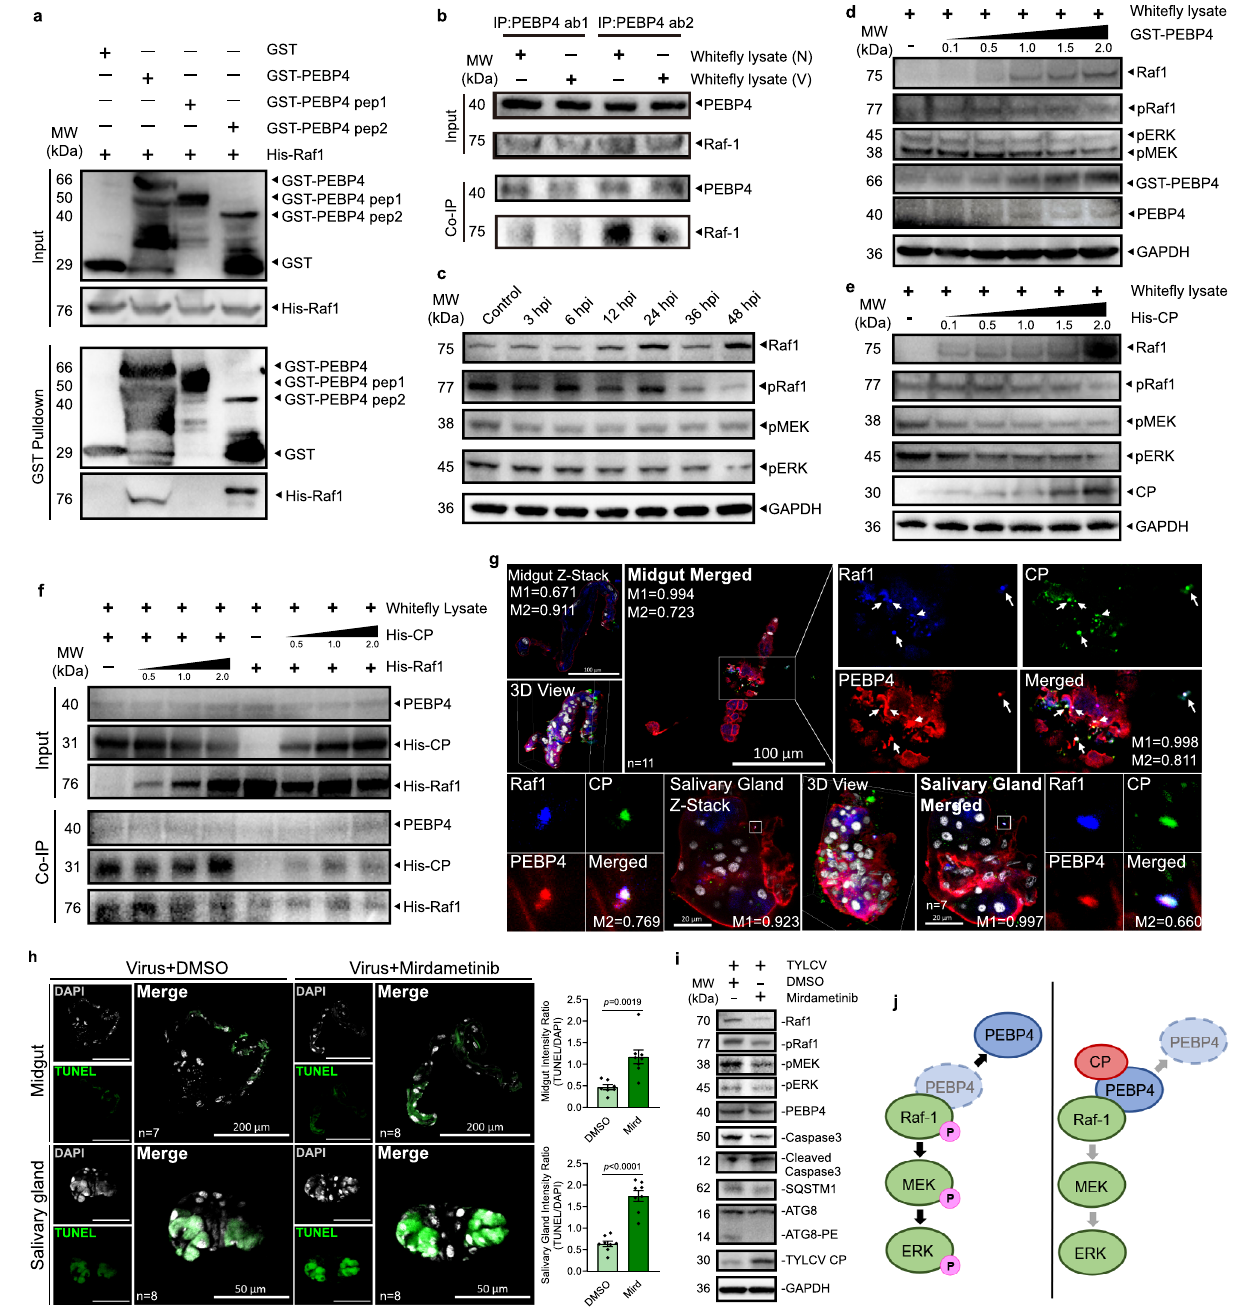
Fig. 4 PEBP4 interacted with Raf1 which negatively regulated MAPK phosphorylation and enhanced the virus-induced apoptosis. a GST pull-down showing the interaction between recombinant His-Raf1 and PE-binding domain of GST-PEBP4. b PEBP4 co-immunoprecipitated with Raf1 in viruliferous (V) or nonviruliferous (N) white fl y. c Time-course immunoblots of MAPK pathway phosphorylation. d , e Immunoblots of MAPK pathway phosphorylation in white fl y lysate when co-incubated with a concentration gradient of d PEBP4 and e TYLCV CP. f His-CP and His-Raf1 of different concentrations were co- incubated in white fl y lysate, and co-immunoprecipitated with PEBP4. g Raf1 (blue), PEBP4 (red), and CP (green) were simultaneously labeled in immuno fl uorescence assays. Colocalization was quanti fi ed by ImageJ Coloc2 using Manders ’ Colocalization Coef fi cients (MCC). M1 = PEBP4-Raf1/Total Raf1; M2 = CP-Raf1/Total Raf1. h , i After 24 h feeing on mirdametinib, a phosphorylation inhibitor of MEK, white fl ies were transferred to virus-infected host plants for another 24 h to acquire TYLCV. The midgut and salivary gland were dissected for h TUNEL labeling (green). Nuclei were stained by DAPI (white). Sample sizes ( n ) for statistical tests indicated in the panels refer to biologically independent white fl y. Values in bar plots represent mean ± SEM. All data were checked for normality by the Wilk-Shapiro test. Two-sided paired t -test was used to separate the means of normally distributed data. i Immunoblot of phosphorylation of MAPK pathway and initiation of apoptosis. j Model of CP-PEBP4 regulation on MAPK cascade in white fl y. CP stabilized Raf1-PEBP4 interaction, which blocked the MAPK phosphorylation cascade.